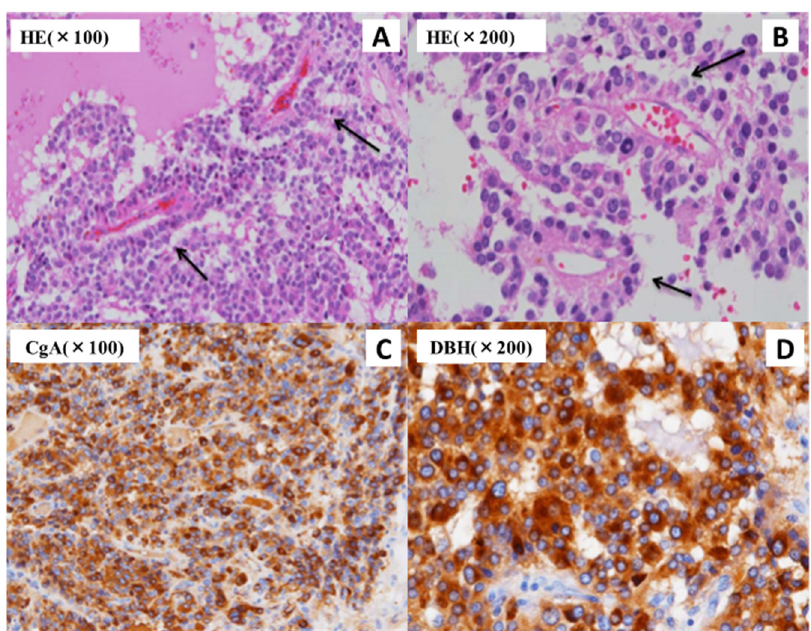
Figure 4. The pathological findings in the present case reveal an adrenal tumor. Small-sized cell tumors with large round nuclei, scant cytoplasm, and high-intensity chromatin are observed using hematoxylin-eosin (HE) staining. A perivascular pseudorosette pattern (black arrow) is also observed ( A , B ). The immunohistochemical detection of chromogranin A (CgA) ( C ) and dopamine β -